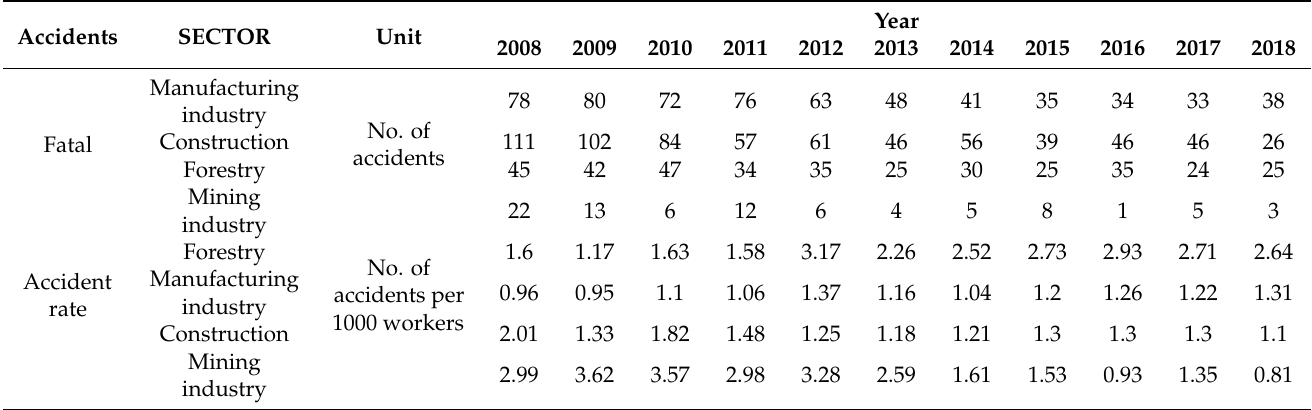
Table A2. Accidents in Romania related to different